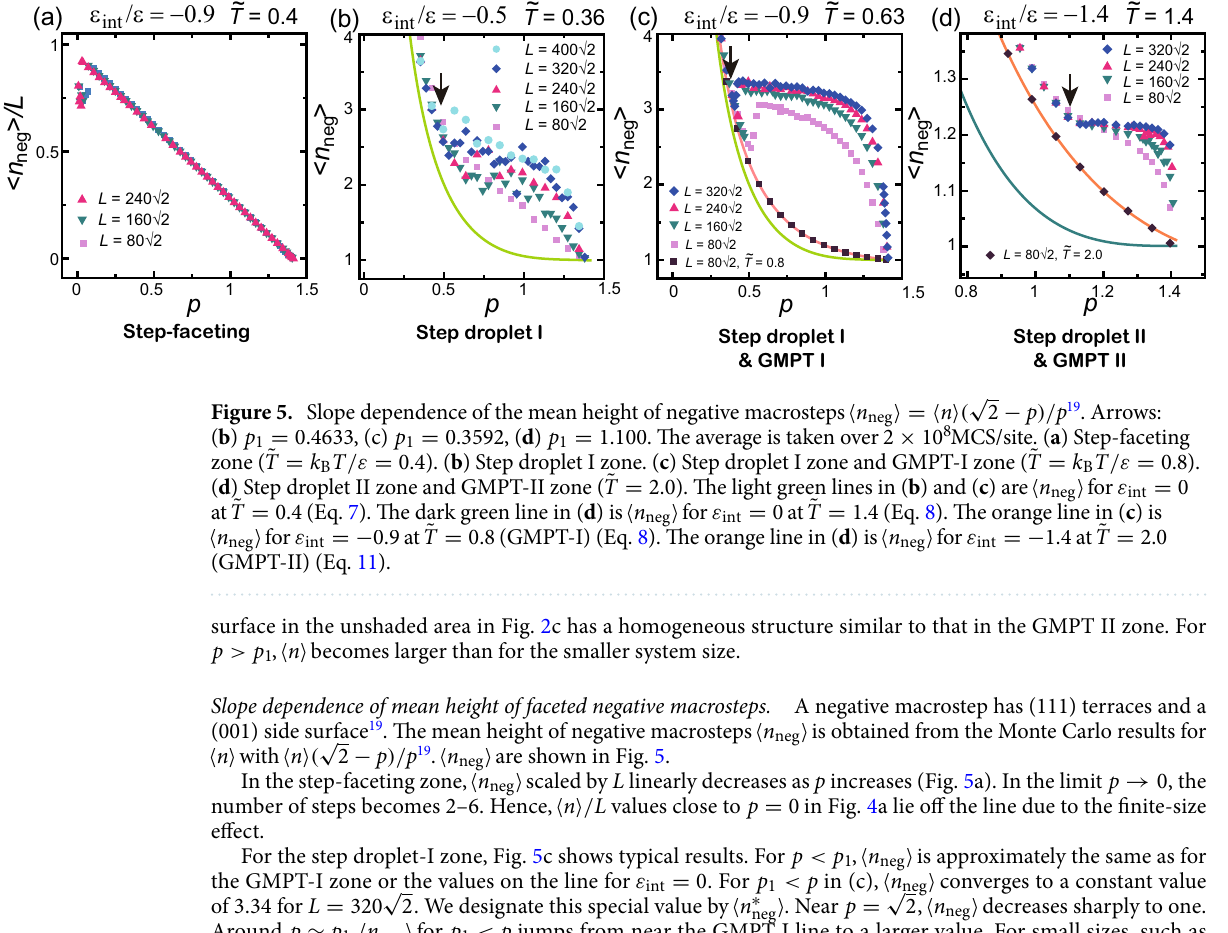
320 √ 2 . We designate this special value by =